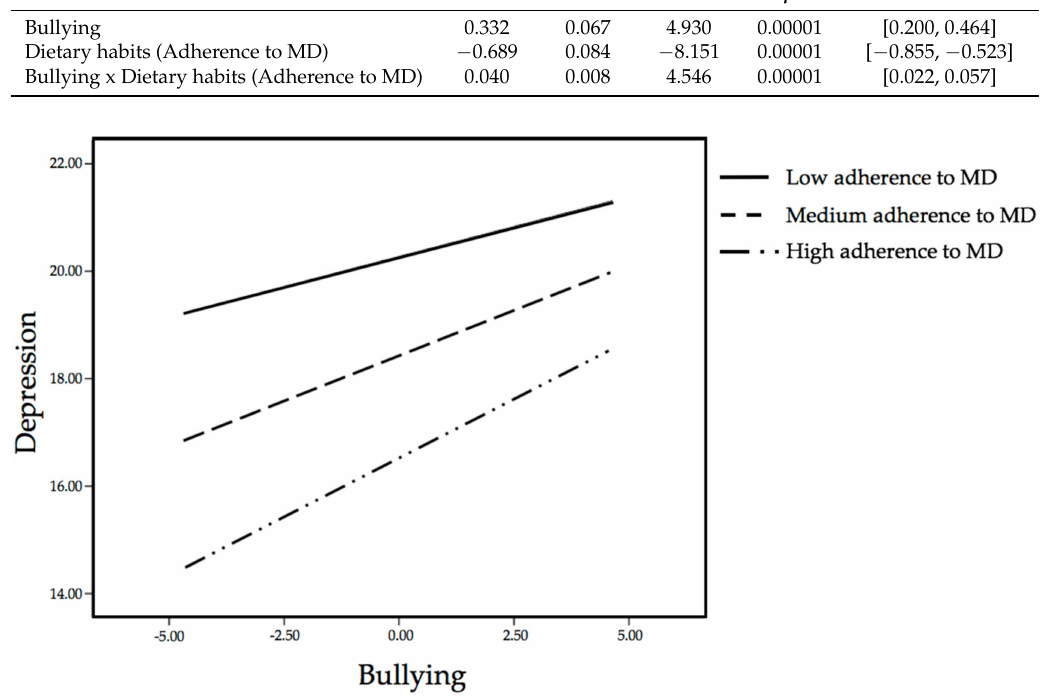
Figure 1. Graphical representation of the moderation of dietary habits (adherence to MD) on the association between bullying and